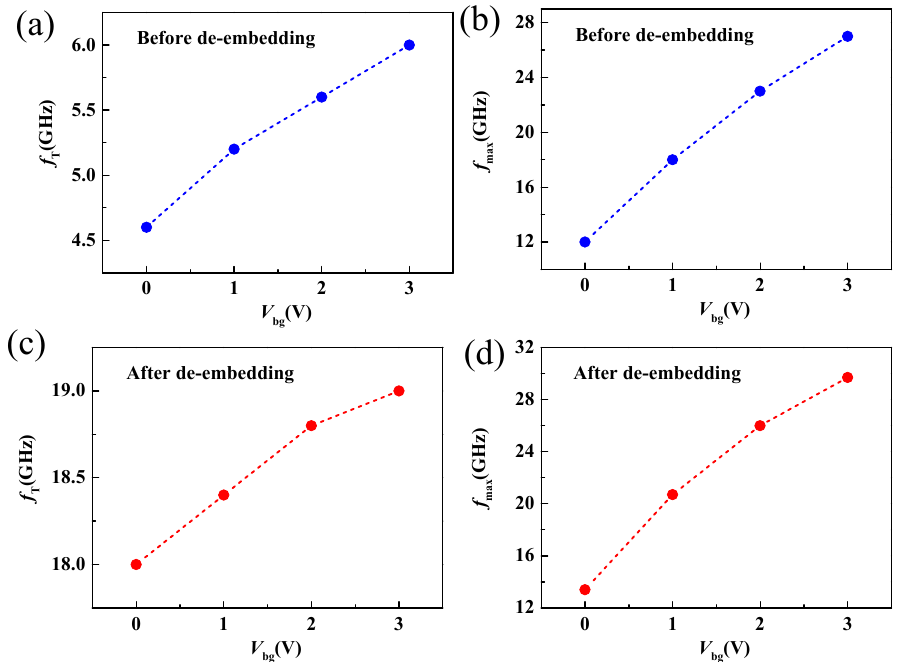
Figure 7. ( a , b ) Extrinsic f T and f max as a function of V bg . ( c , d ) Intrinsic f T and f max as a function of V bg . Table 1. Comparison of reported MoS 2 RF transistors with comparable gate length.